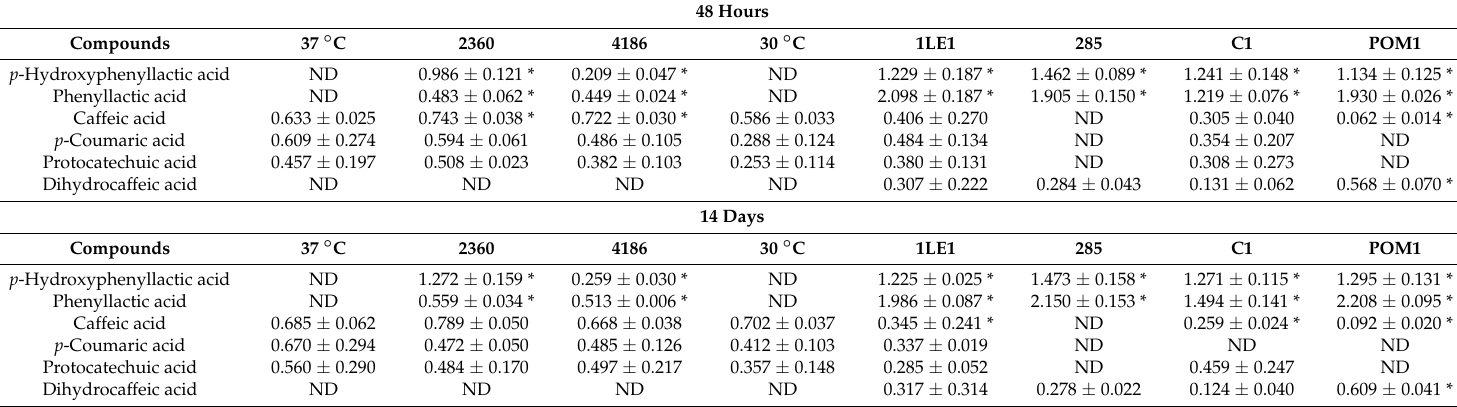
Table 4. Phenolic compounds. Phenolic compounds ( µ g/mL) metabolized by lactic acid bacteria during cherry juice fermentation and further